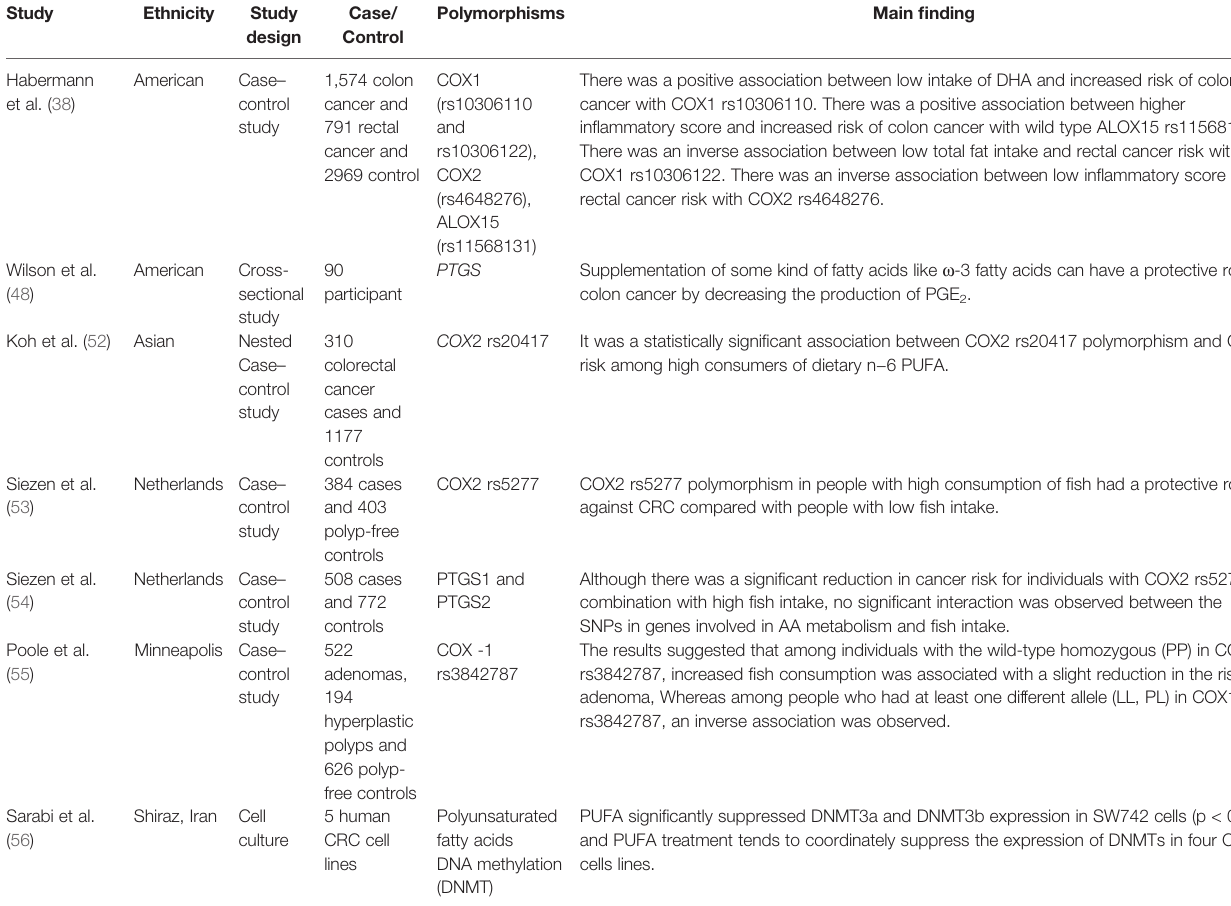
TABLE 3 | Summary of studies regarding interactions between ALOX, COX polymorphism, dietary fatty acid, and CRC